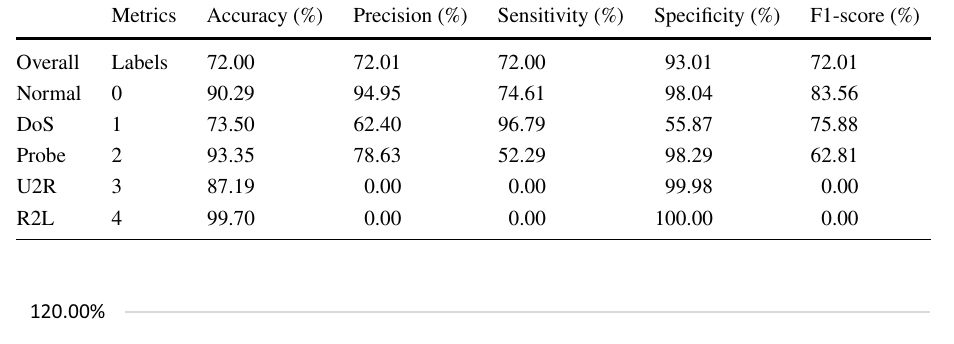
Fig. 2 Model performance on the attack types before feature selection